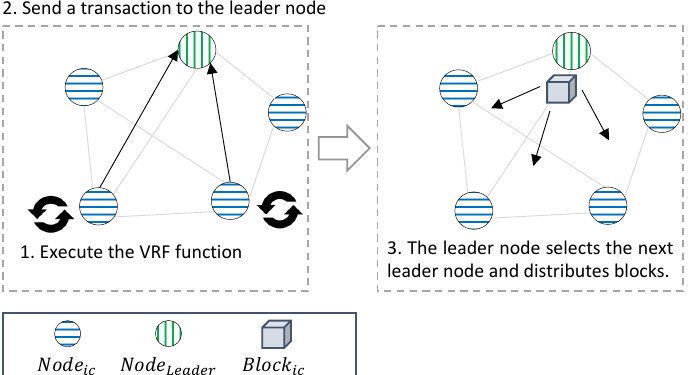
Figure 5. Block ic generation process: ( 1 ) Node ic executes the VRF function when TX is created, returns Val rand , and encrypts data with its own Key priv and Sig. After generation, Node leader is checked to generate the next block in the last block of the blockchain and to send TX . ( 2 ) The TX structure, Sig , and Val rand of Node leader that received TX are verified. ( 3 ) If all Val rand are verified, the node with the largest Val rand among the nodes that transmitted TX is selected as the next Node leader , recorded in a block, and distributed to all